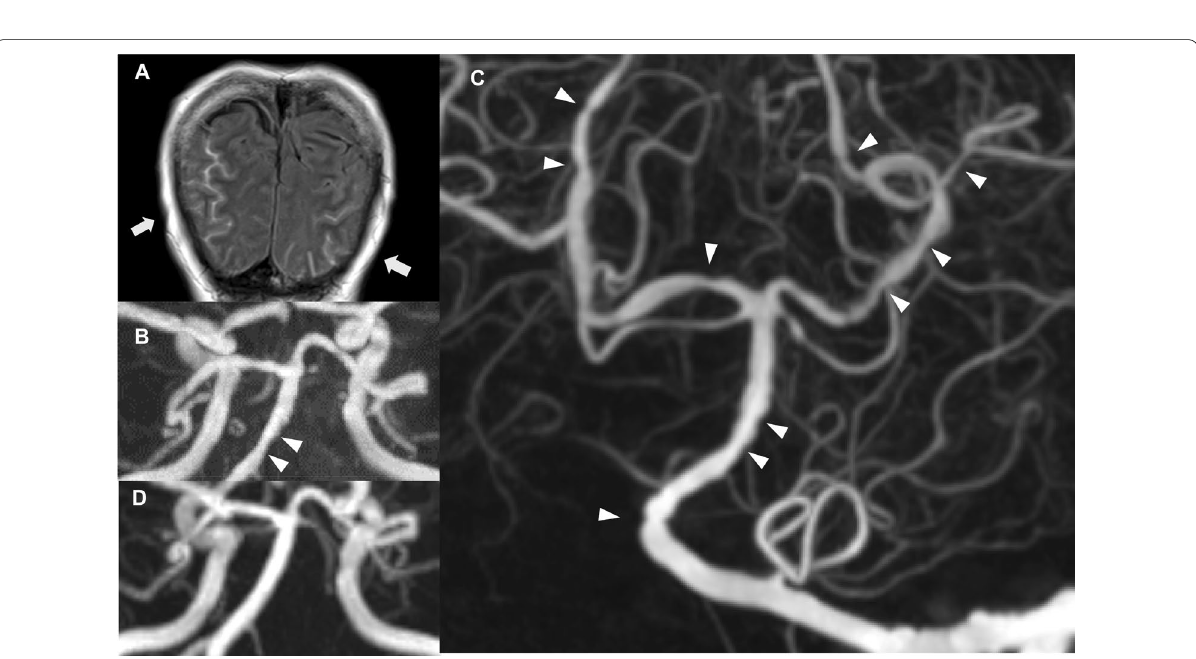
Fig. 4 MRI images of the head. A Fluid-attenuated inversion recovery image on day 24 of hospitalization. The high-signal area along the sulcus suggested SAH (white arrows). B MRA image on day 24 of hospitalization, showing wall irregularity in the basilar artery (white arrowheads). C Cerebral angiography on day 26 of hospitalization. No signs of cerebral aneurysm were observed. Wall irregularities are visible in the left vertebral artery, basilar artery, and bilateral posterior cerebral arteries (white arrowheads). D MRA image 5 months after discharge. The irregularities in the wall of the basilar artery had completely disappeared. MRA magnetic resonance angiography, MRI magnetic resonance imaging, SAH subarachnoid